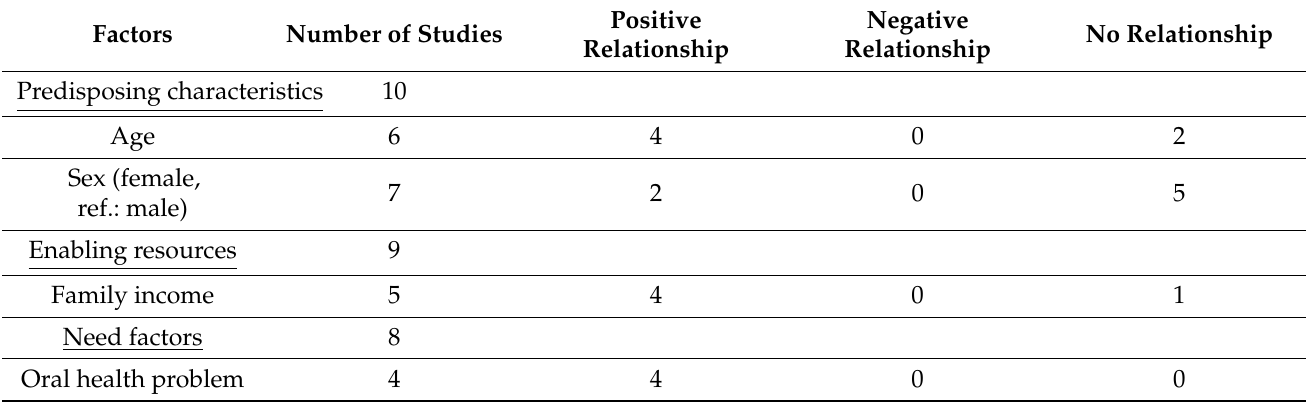
Table 4. Key findings (children/adolescents).